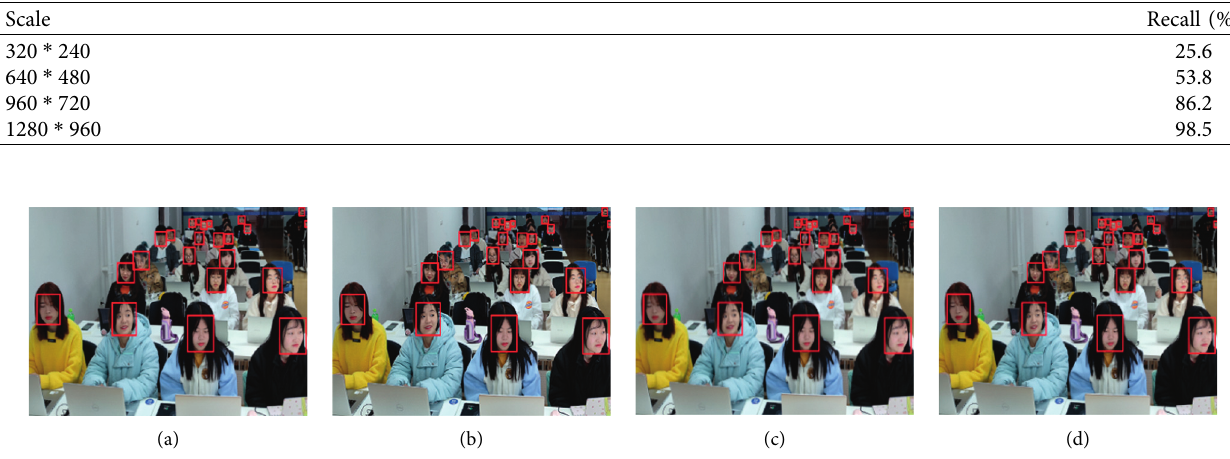
Table 5: Influence of different scales on the recall rate of face detection.